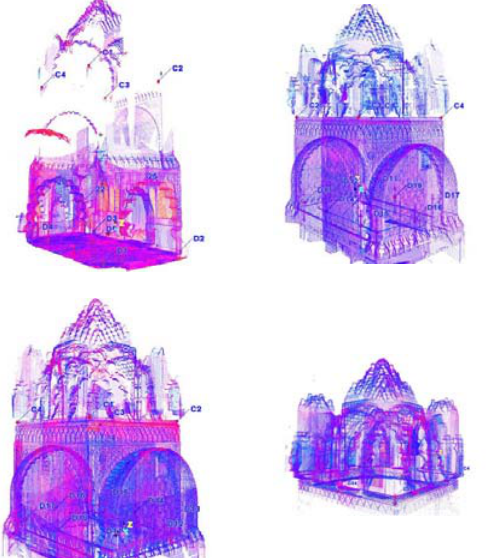
Figure 5. Scan phases and number of scan stations. 1 st phase, 7 scans (upper left); 2 nd phase, 5 scans (upper right); 3 rd phase, 1 scan (lower left); and 4 th phase, 17 scans (lower right).